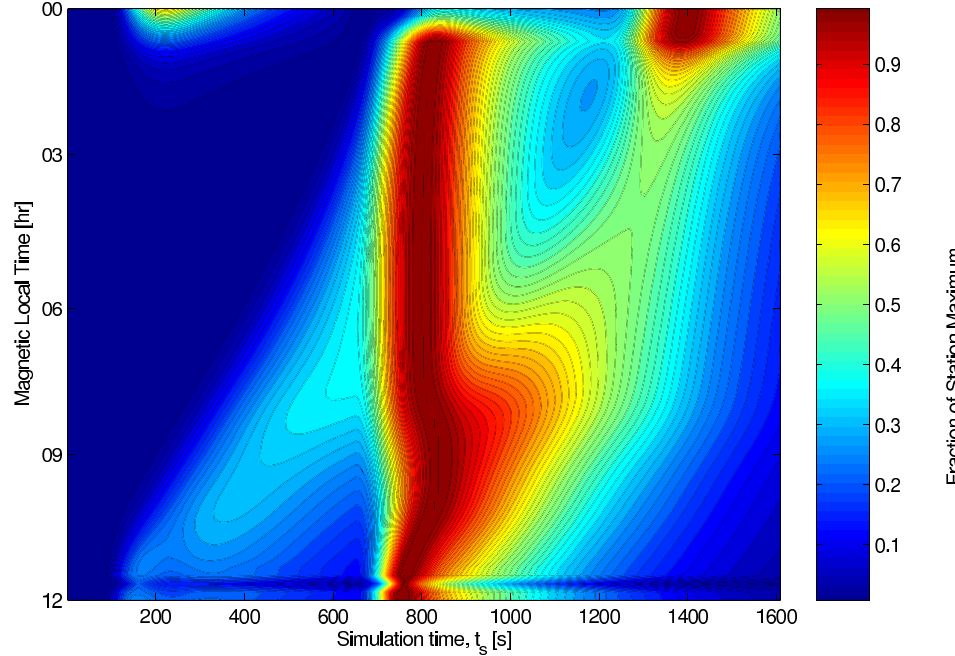
Fig. 8. Same as Fig.6, but for a reconnection pulse separation of 10min.